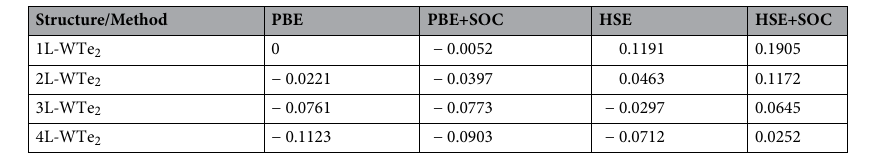
Table 2. Electronic band gap values (in eV) calculated within PBE and HSE06 functionals without and with SOC for 1L, 2L, 3L and 4L 1T ′ WTe 2 . The band gap is calculated as the energy difference between the conduction band minimum and valence band maximum, E CBM − E VBM